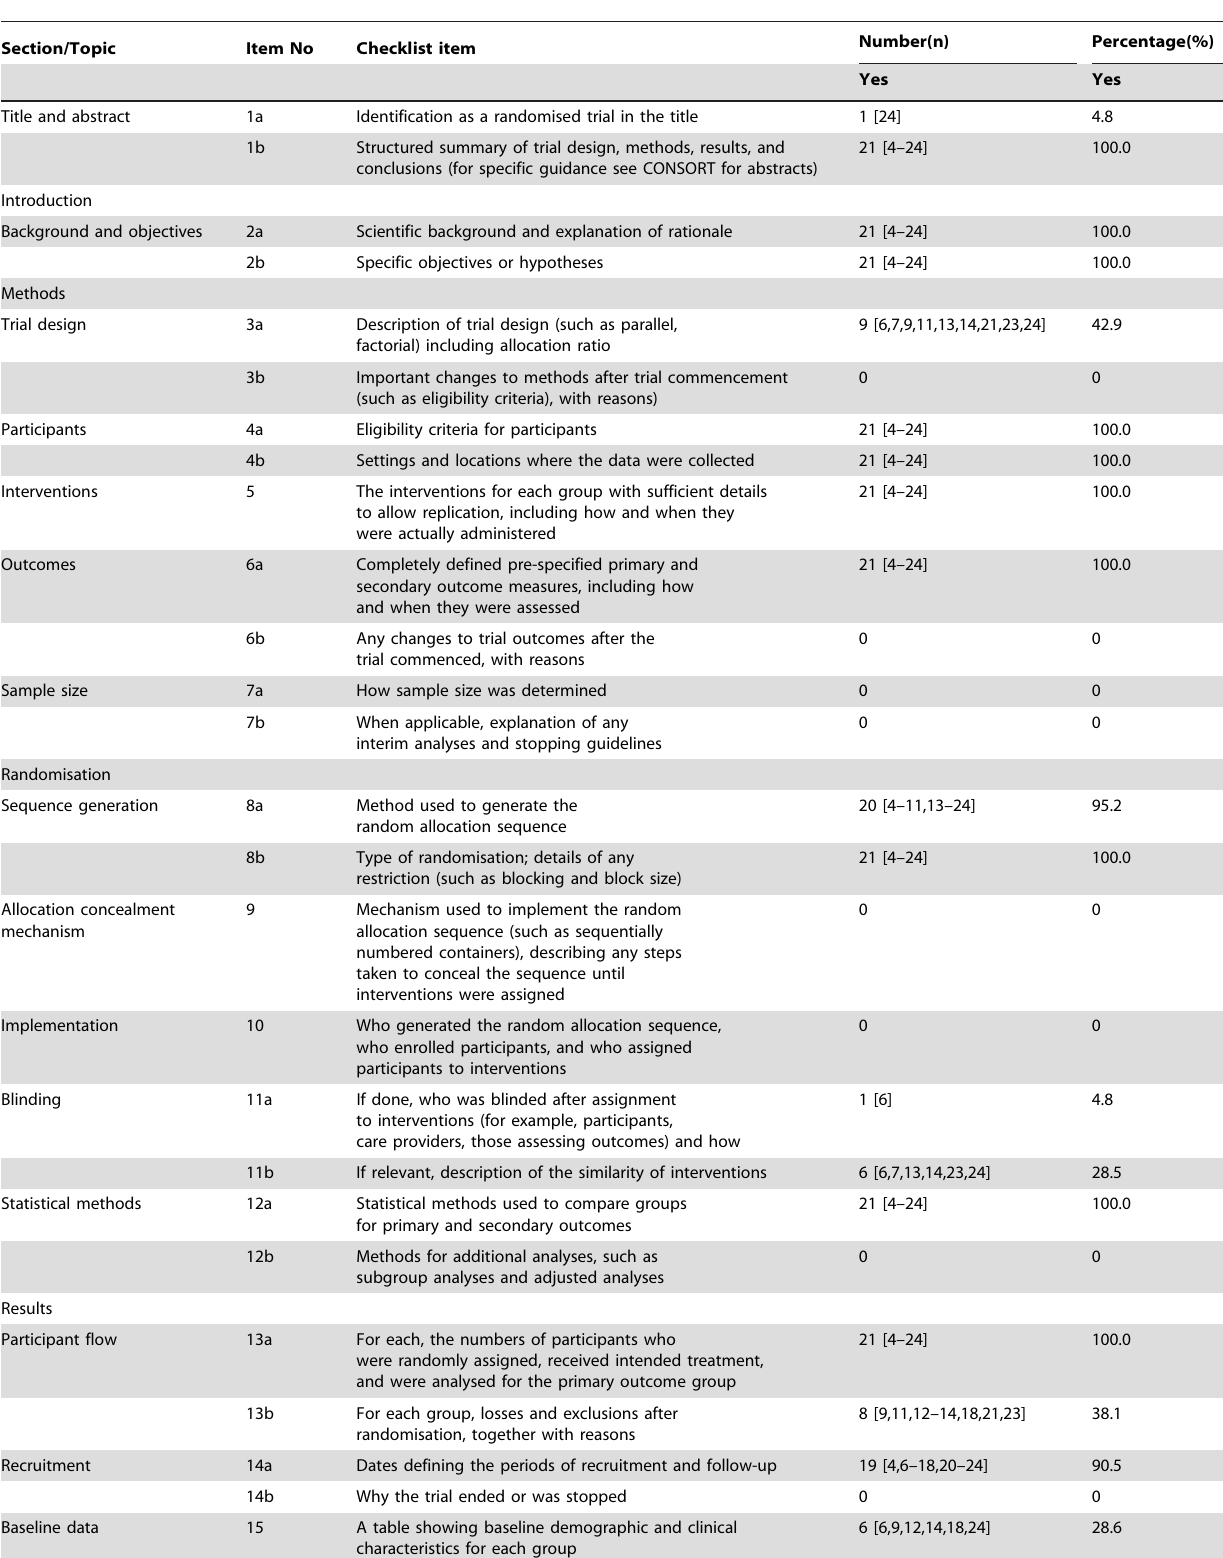
Table 2. The reporting number and percentage for each item of the CONSORT checklist in CJITWM.